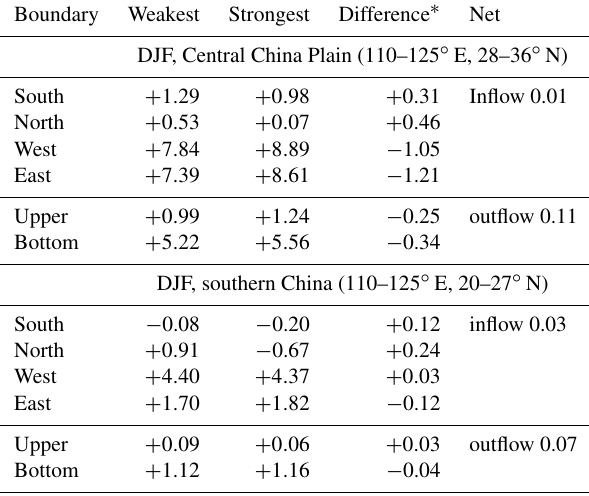
Table 5. The composite analyses of DJF horizontal and vertical fluxes of BC (kgs − 1 ) for two selected boxes (the Central China Plain (110–125 ◦ E, 27–36 ◦ N) and southern China (110–125 ◦ E, 20–27 ◦ N), from 1 to 6km) based on simulation VMET. The values are averages over the 5 weakest and 5 strongest EAWM years dur- ing 1986–2006. For fluxes, positive values indicate eastward, north- ward, or upward transport and negative values indicate westward, southward, or downward